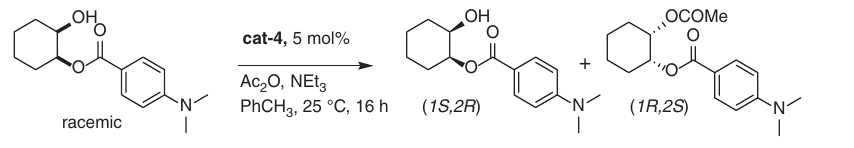
Scheme 8 Kinetic resolution of mono-protected cis -diol catalyzed by cat-4.